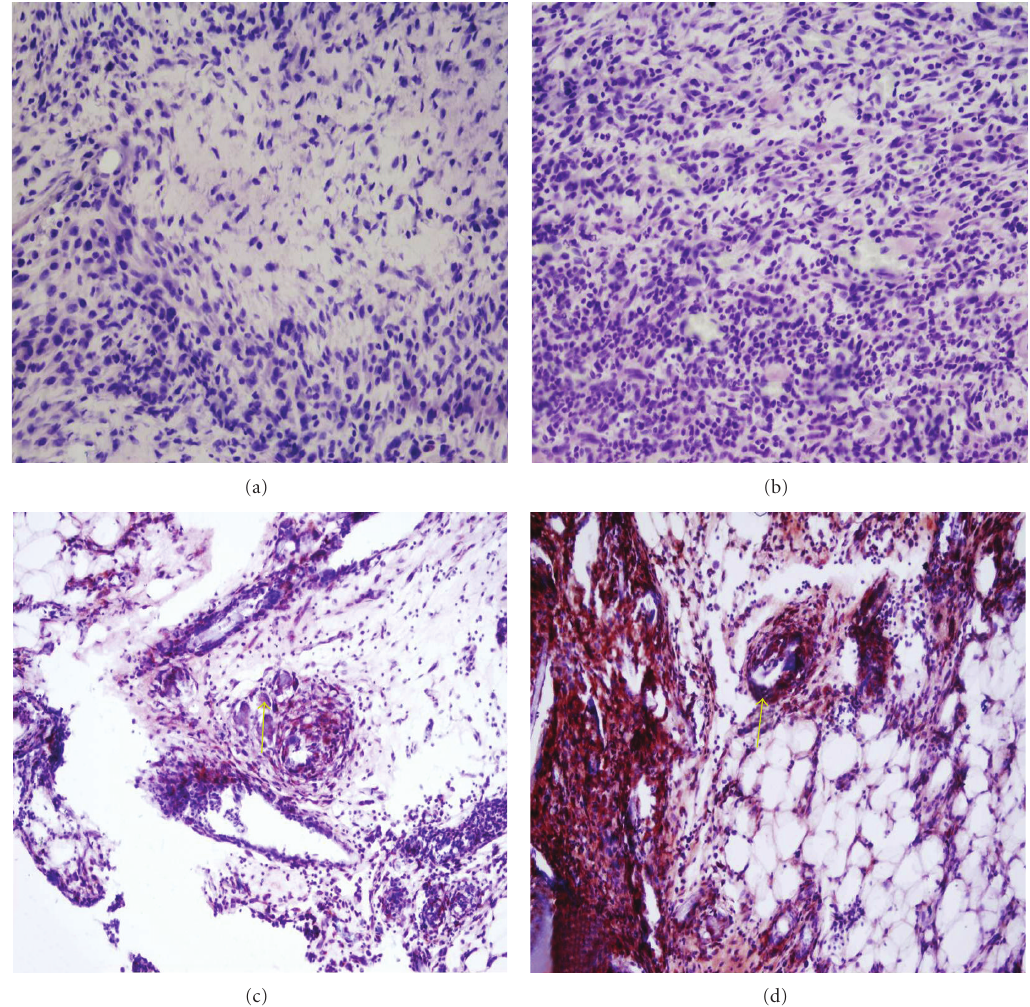
Figure 2: Immunohistochemistry for VEGF. No staining (a), suspected staining (b), moderate staining (c), and strong staining (d).